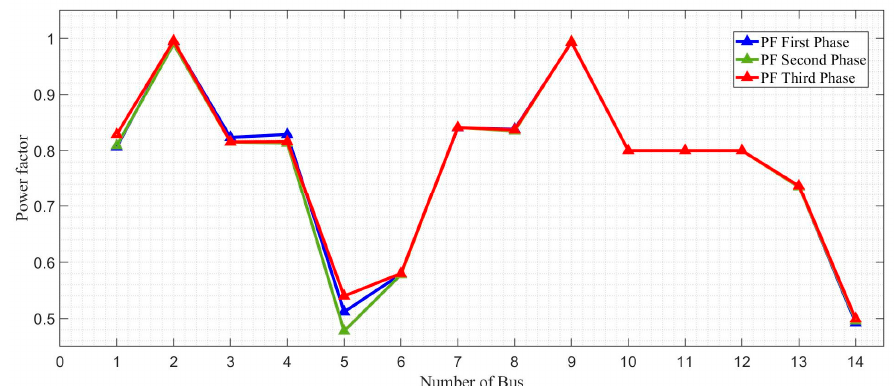
Figure 18. Maximum demand power-factor.